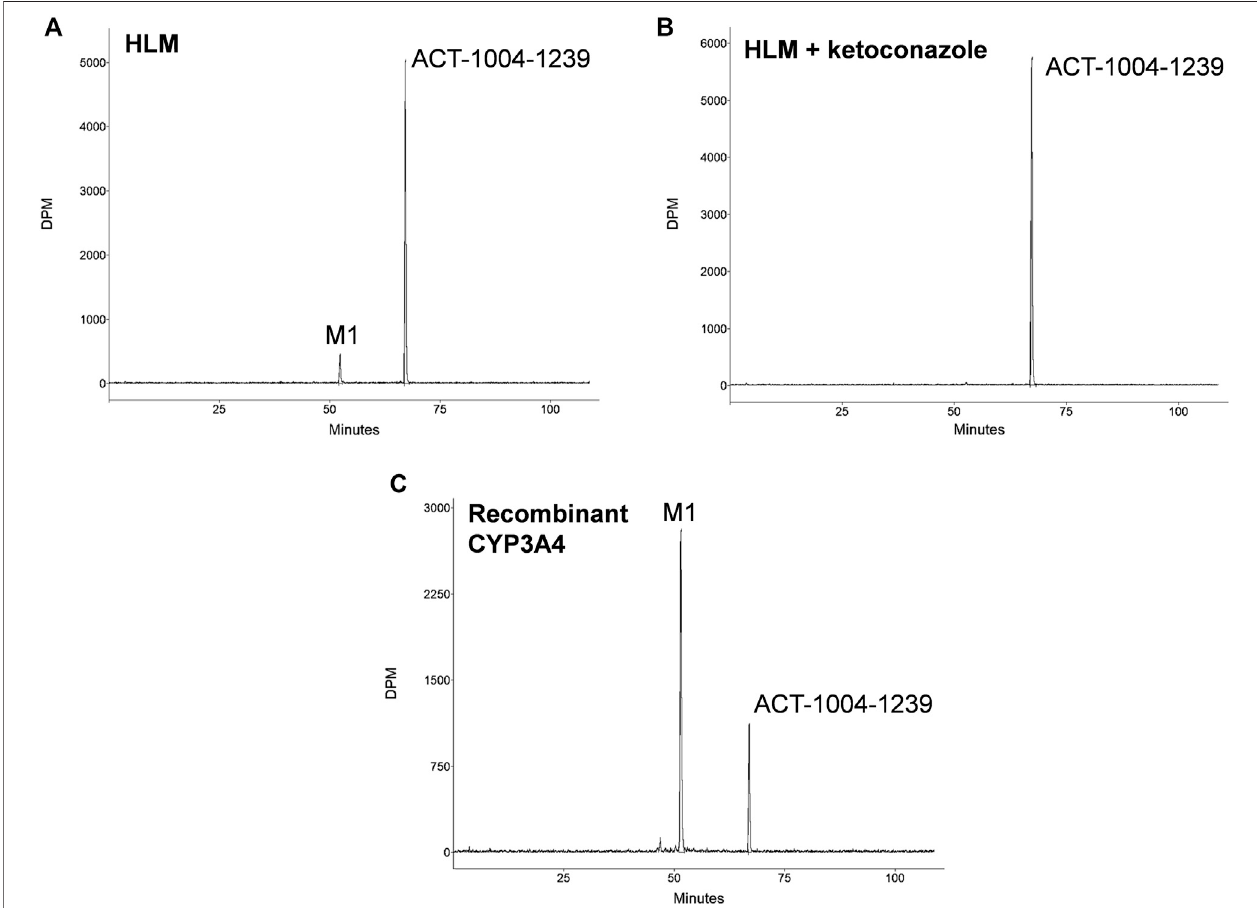
FIGURE1| Invitro studies:metabolicpro fi lesofACT-1004-1239followingincubationwith (A) humanlivermicrosomes(HLM), (B) HLMand1 μ Mketoconazole,or (C) recombinant CYP3A4.